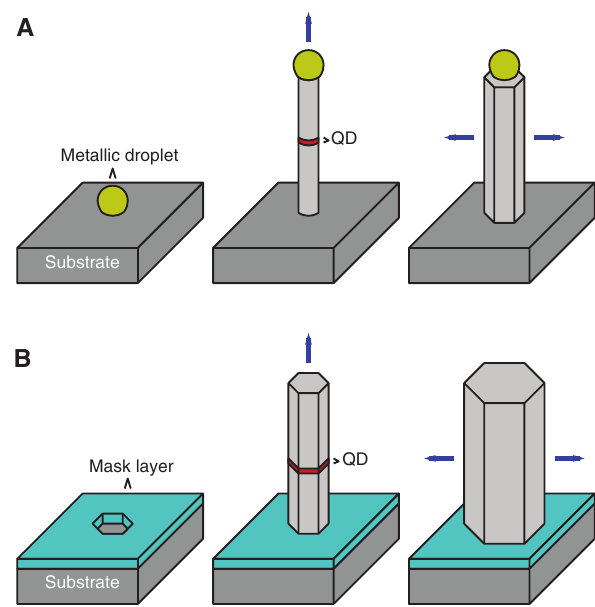
Figure 4: Schematic illustration of the nanowire growth modes. (A) VLS growth mode where axial growth is mediated by a metallic droplet (typically Au). (B) SAE growth mode where growth takes place at an opening in a mask layer. Radial growth takes place via direct vapor—solid growth in both modes. The growth direction (axial or radial) is indicated with blue arrows, and heterostructure insertions (QDs) are indicated with red color. The ideal case is depicted here, where axial and radial growth can be independently controlled to obtain the desired nanowire